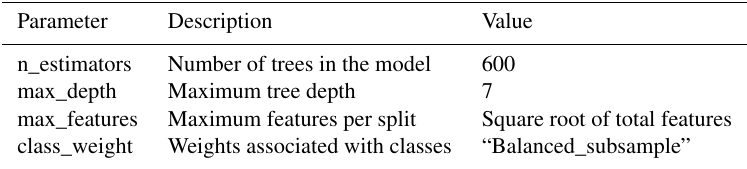
Table C4. Random forest model configuration of